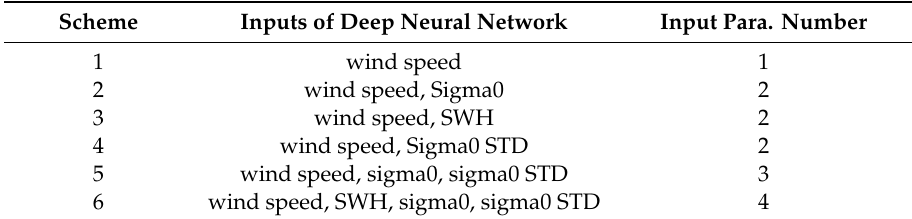
Table 3. Input schemes of DNN for wind calibration (Sample# 127).